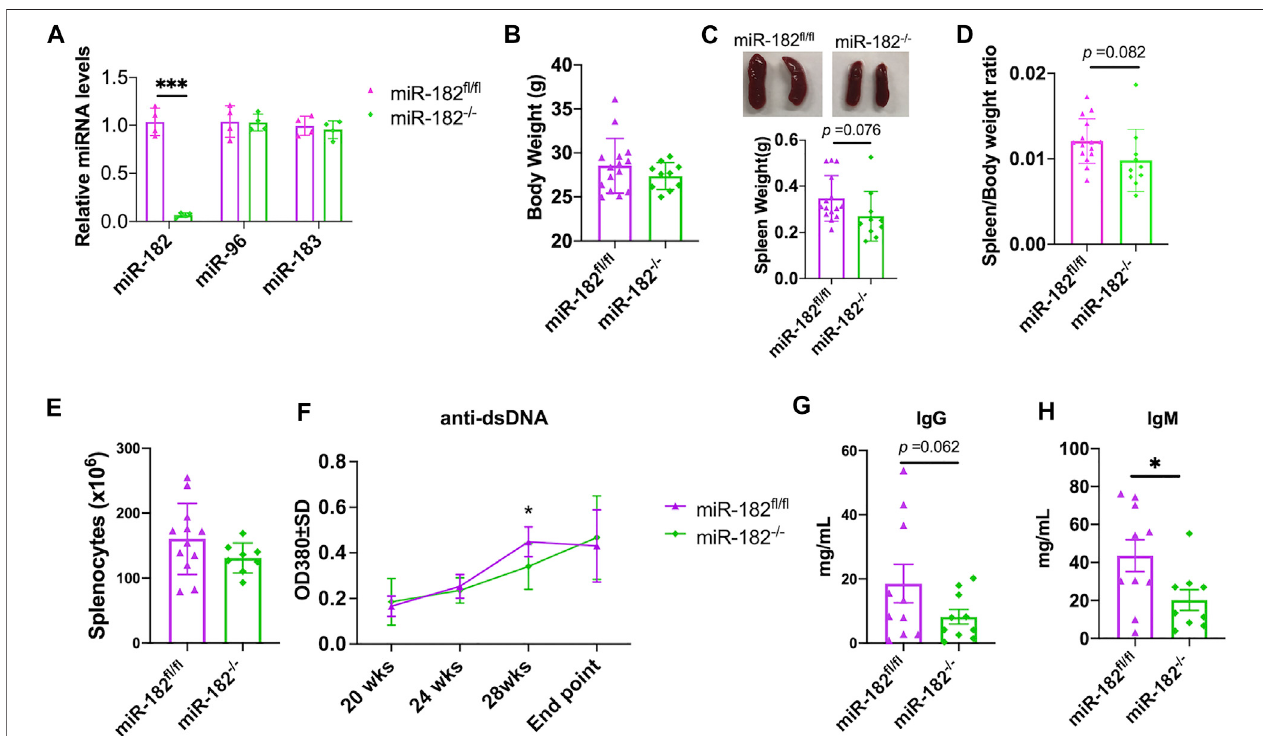
FIGURE 3 | Analysis of the effect of miR-182 deletion on body weight, spleen weight, and antibody production. (A) miRNA TaqMan assay was performed to validate the speci fi c deletion of miR-182, but not miR-96 and miR-183 in splenocytes of miR-182 − / − B6/lpr (miR-182 − / − ) mice. The graph showed means ± SD ( n = 4 each). (B – E) DeletionofmiR-182alonehadnoobviouseffectonbodyweight (B) andsplenocytecounts (E) ,butledatrendofreductionofspleenweight (C) andspleen/ body weight ratio (D) . The miR-182 − / − and control miR-182 fl / fl B6/lpr (miR-182 fl / fl ) mice were euthanized at 29 – 32 weeks of age (end point) for sample collections. Graphsshowedmeans±SD( n ≥ 8). (F) DeletionofmiR-182hadminimaleffectonserumanti-dsDNAautoantibodies.Theserumanti-dsDNAautoantibodylevelsinmiR- 182 − / − and miR-182 fl / fl mice were monitored every 4 weeks starting at 20 weeks of age. Data were shown as means ± SD ( n = 6 for miR-182 − / − mice at different time points except n = 15 for the end point; n = 7 for miR-182 fl / fl mice at different time points except n = 15 for the end point) (G,H) Evaluation of serum levels of total IgG (G) and IgM (H) antibodies in miR-182 − / − and miR-182 fl / fl mice at the end point. Graphs showed means ± SD ( n = 10 each). Unpaired student t tests were performed (miR- 182 fl / fl vs . miR-182 − / − ); *, p < 0.05; ***, p <